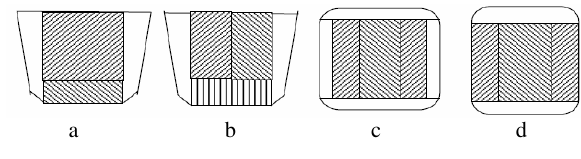
Fig 3. Tanker design types (section looking forward): a, b – double hull with horizontal longitudinal bulkhead across; c – double hull and double bottom; d – single hull and double